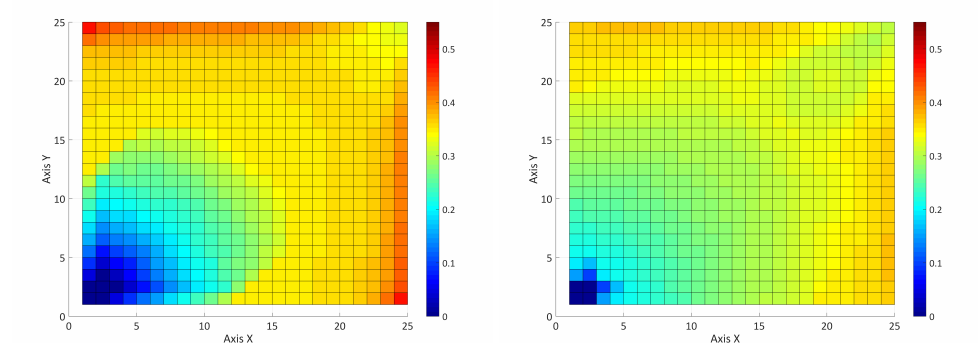
Figure 8. Oil concentration after 3000 days, at the end of the EOR process, for an overlapped polymer + surfactant ( left ) and surfactant + polymer ( right ) SP flooding.